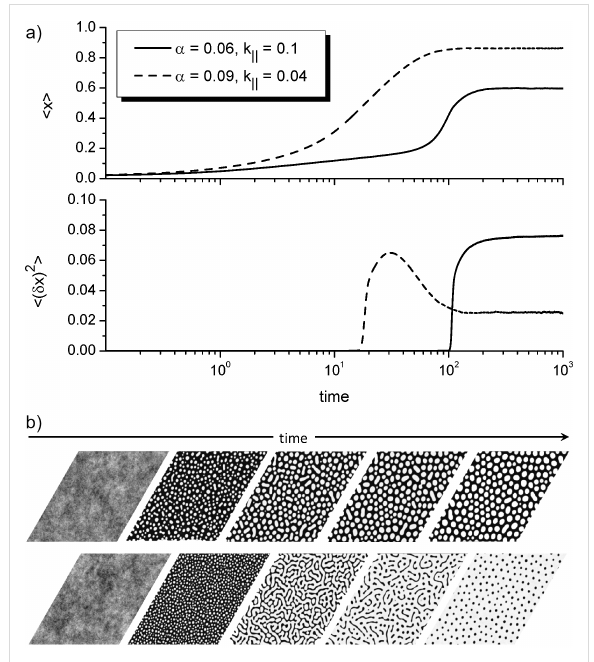
Figure 3: Evolution of the mean adsorbate concentration ⟨ x ⟩ (top panel in Figure 3a) and the dispersion ⟨ ( δ x ) 2 ⟩ (bottom panel in Figure 3a). Figure 3b shows snapshots of the system evolution for two different cases, that is, close to left border of the domain of pattern for- mation at α = 0.06 and k ∥ = 0.1 (top panel) and close to right border of the domain of pattern formation at α = 0.09, k ∥ = 0.04 (bottom panel). The adsorbate concentration on the substrate is shown in the gray scale from black for x = 0 to white for x =